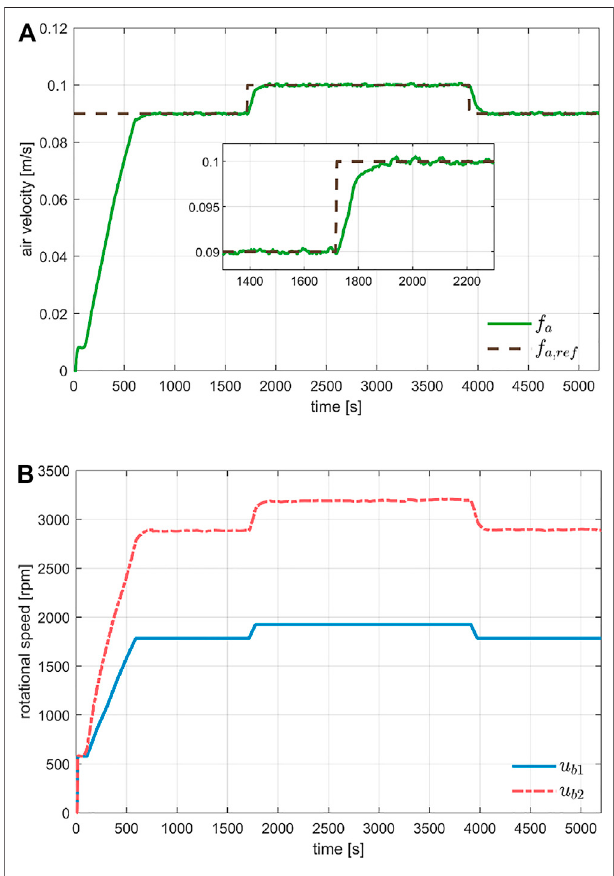
FIGURE 4 | Evaluation of air velocity control during system startup and sudden changes of the set-point. Plot (A) shows the tracking performance under different step changes, while Plot (B) the commanded rotational speed for the two blowers.